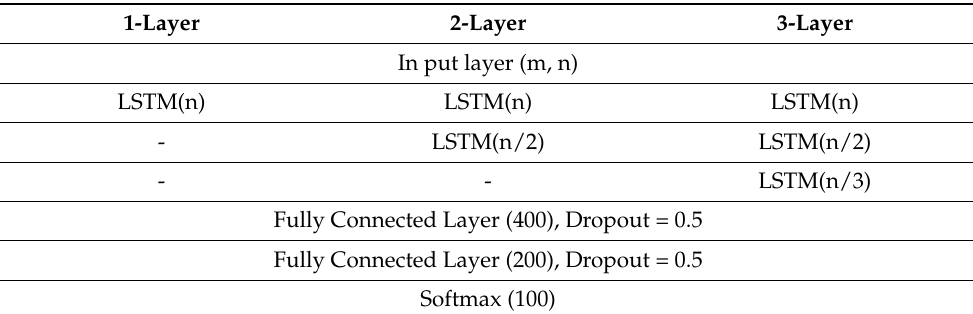
Table 5. Hyperparameter of LSTM.